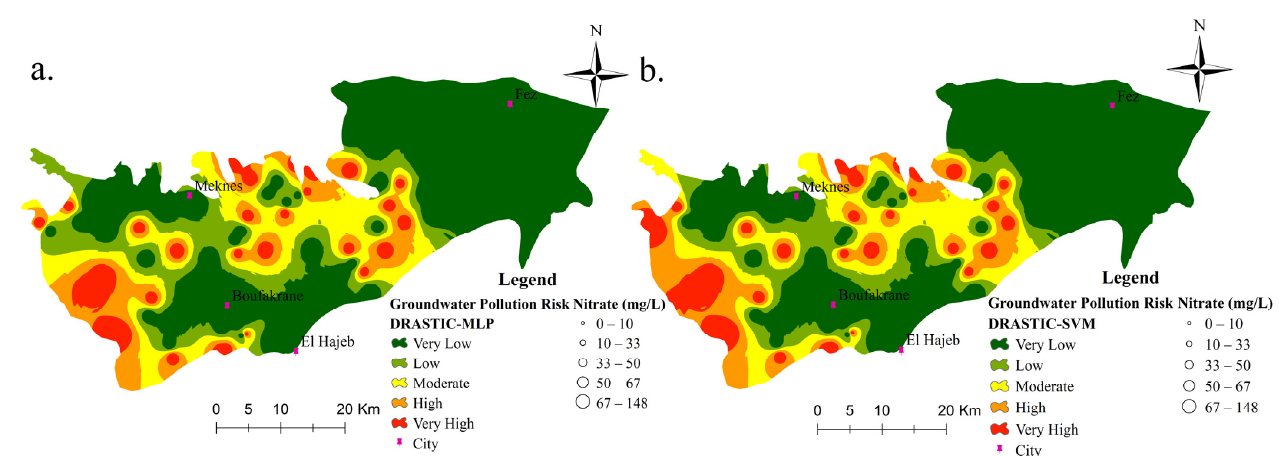
Figure 6. Percentages of groundwater pollution risk classes for the applied models in this study.